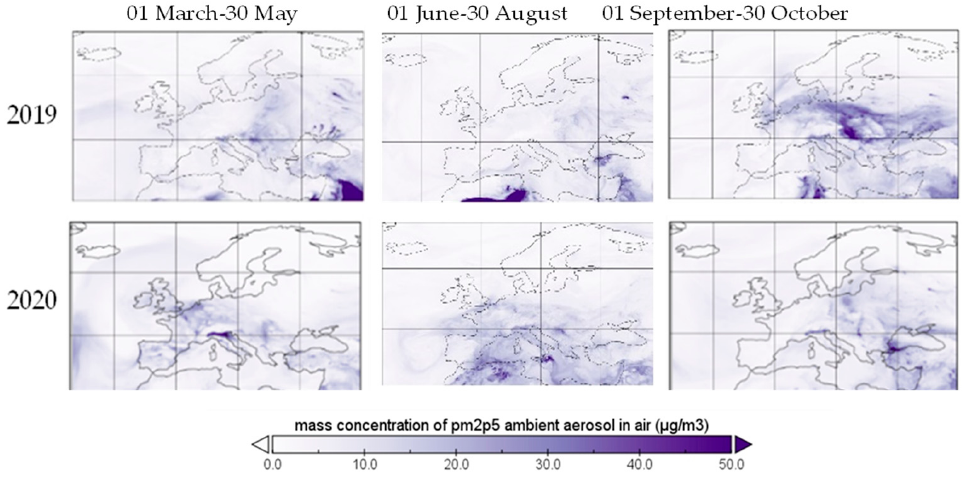
Figure 13. PM 2.5 over Europe during restriction period, 2019 and 2020.